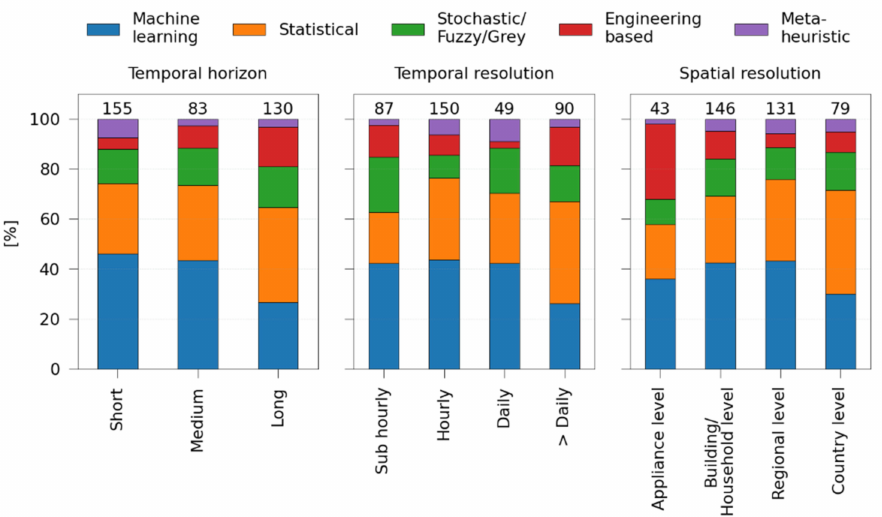
Figure 8. The relative share of categories of techniques by the temporal horizon and spatio-temporal resolution. The left figure shows that ML and metaheuristic techniques are predominantly employed for short-term projections while engineering-based approaches are used for longer timeframes. The middle figure shows that there is an overall tendency towards hourly time steps. Techniques are used equally across all temporal resolutions, except ML, which decrease for longer time-steps. The right figure shows that buildings, households, and regions are analyzed the most. Engineering-based models stand out in showing a clear tendency towards a high level of